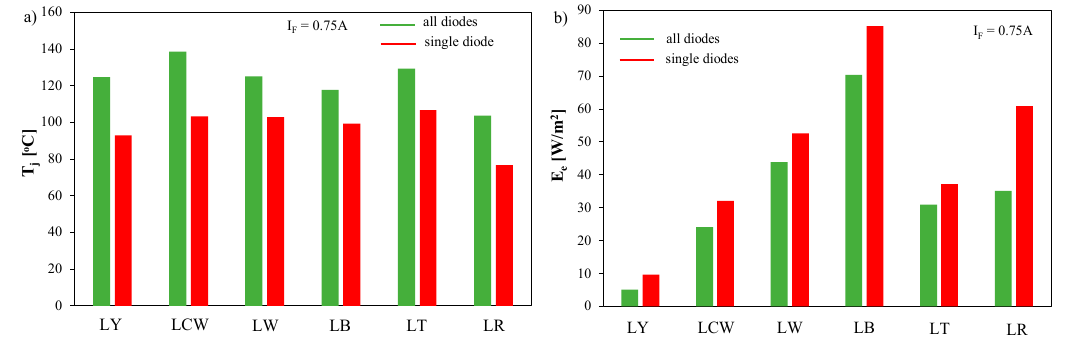
Figure 17. Measured values of junction temperature ( a ) and the surface power density of the emitted light ( b ) for power LEDs operating alone and simultaneously with all other diodes.